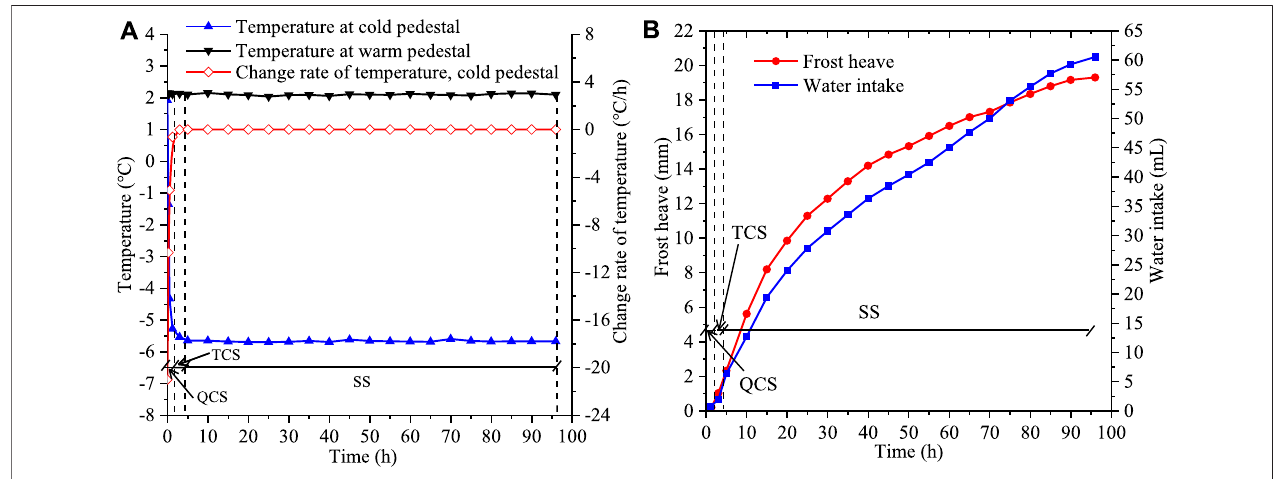
FIGURE7| Freezingresultsofclaysample. (A) Variationsoftemperatureandchangerateoftemperature; (B) variationsofwaterintakeamountandheaveamount.